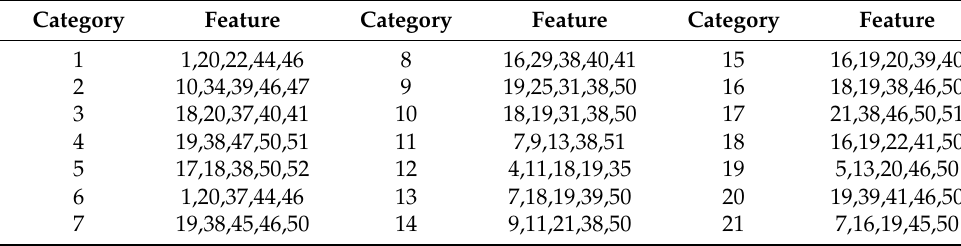
Table 4. Feature selection results of RFtb.